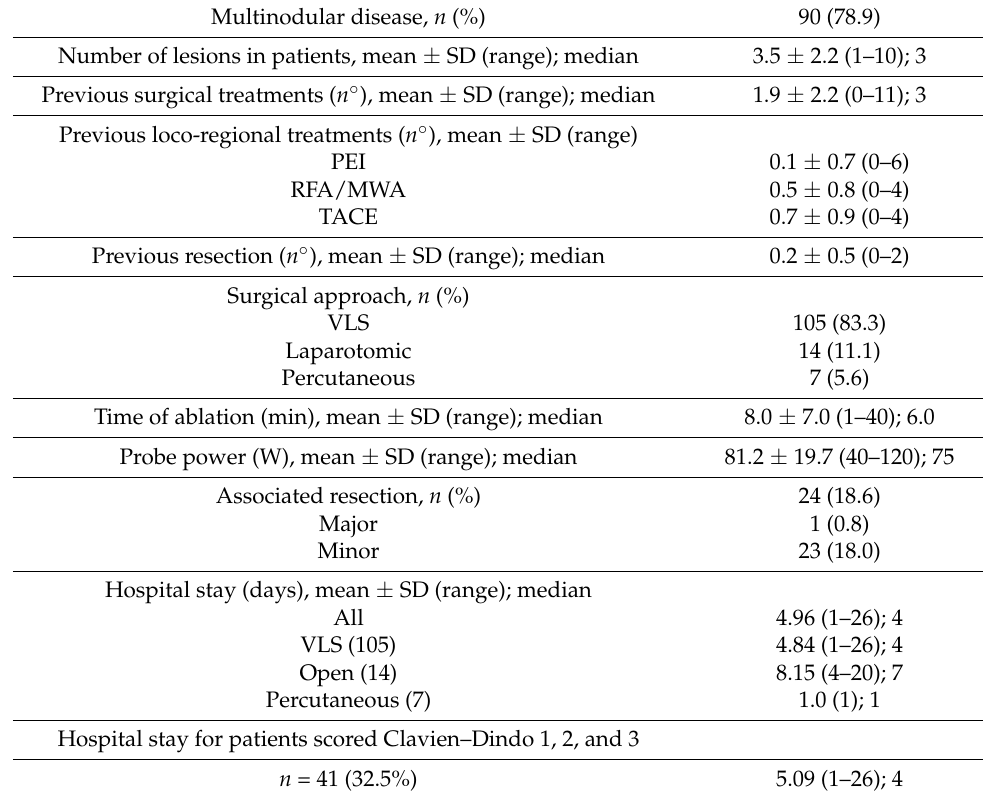
Table 3. Cont. Multinodular disease, n